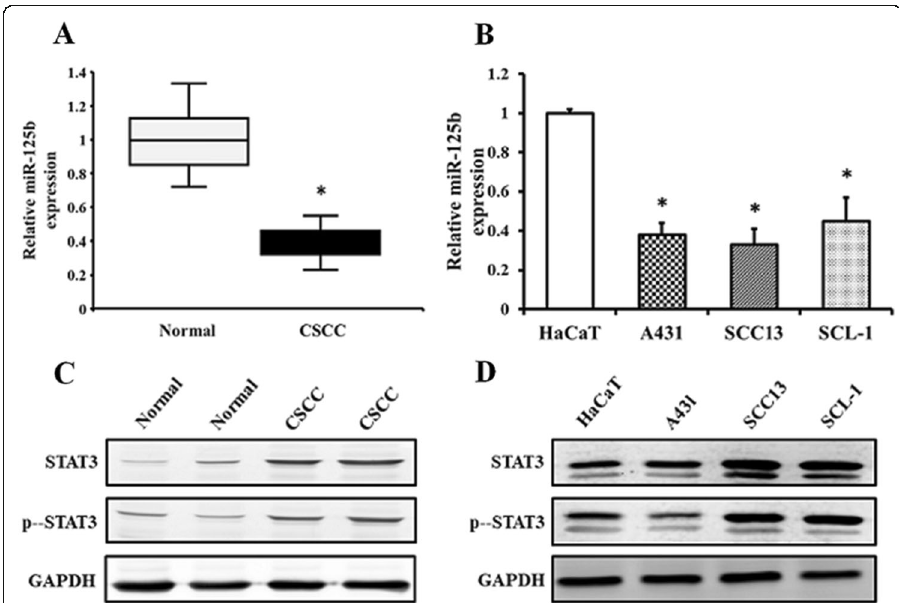
Fig. 1 MiR-125b and STAT3 expression in CSCC tissues and cell lines. a MiR-125b expression in CSCC tissues and adjacent normal tissues. b MiR-125b expression in cells of CSCC cell lines (A431, SCC13 and SCL-1) and a normal skin cell line (HaCaT). c The STAT3 protein level in CSCC tissues and adjacent normal tissues. d The STAT3 total and phosphorylated protein levels in cells of CSCC cell lines (A431, SCC13 and SCL-1) and a normal skin cell line (HaCaT). * p < 0.05 in comparison with normal tissues or cell